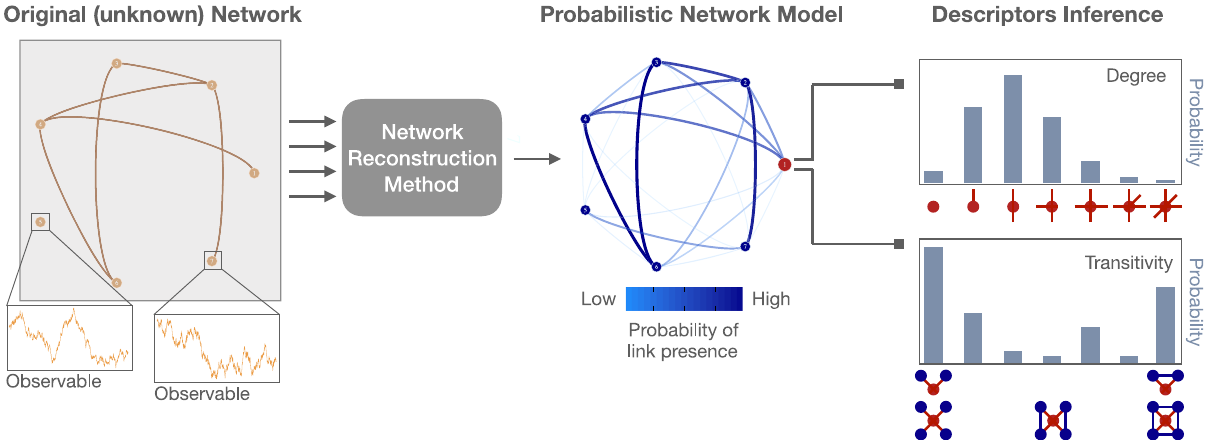
Fig. 4 | Measuring network descriptors under uncertainty. In many practical problems, the structure of a network cannot be directly observed, while signals (e.g., the time course of physical variables) can be measured from its units. After applying a valid reconstruction method as the ones described in Sec. (II), the results can be summarized in a convenient way via a marginal probability of the existenceforeachpairwiselink,attheexpenseofsomelossofinformationpresent in the full joint distribution. Note that the set of those probabilities does not represent a weighted or directed network, and it would be wrong to perform any standard network analysis on the corresponding graph. In fact, in this context,